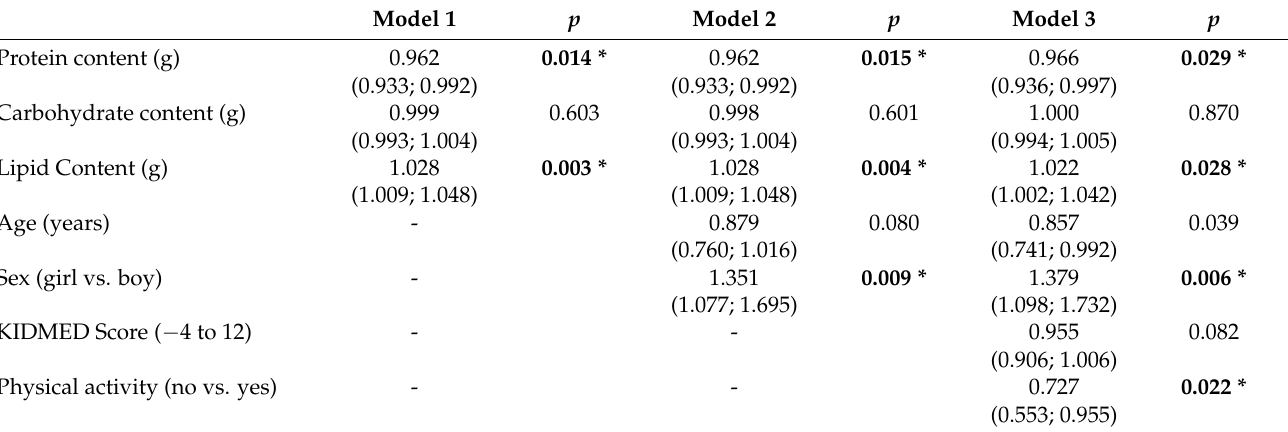
Table 3. Multiple logistic regression models for the evaluation of breakfast’s macronutrient content on children’s weight status, after adjustment for